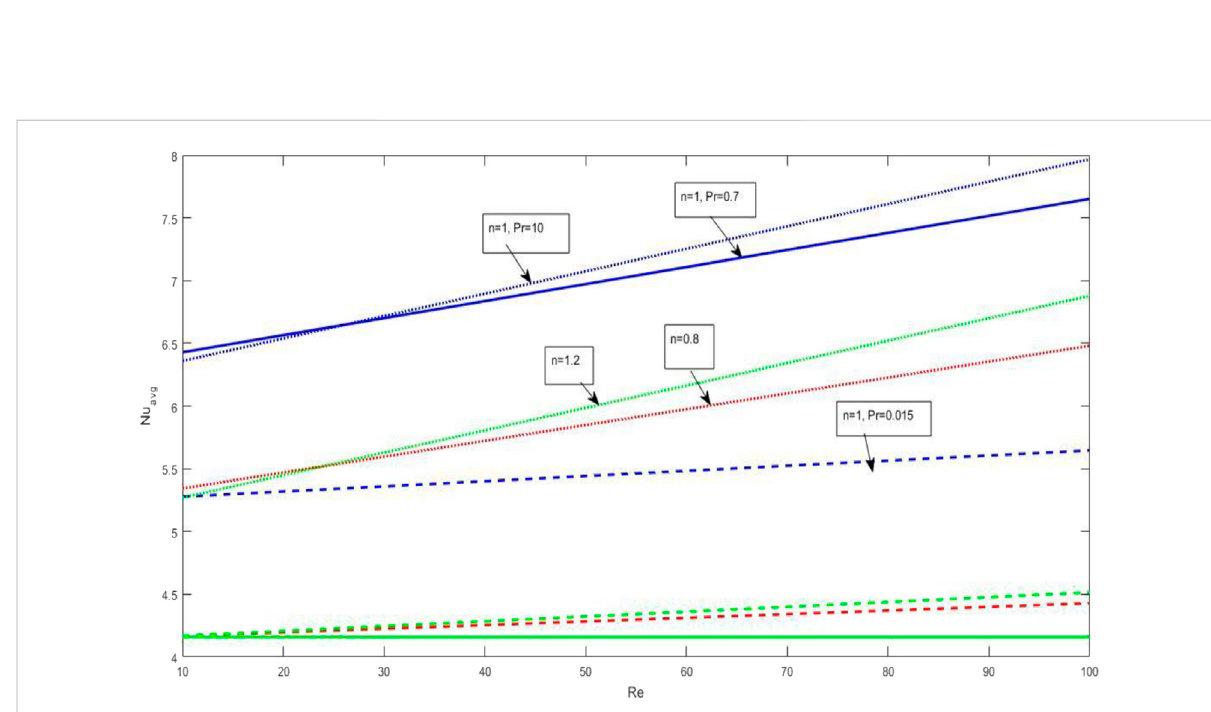
FIGURE 18 Variation in the average Nusselt number ( Nu Avg ) against the Reynolds number ( Re )